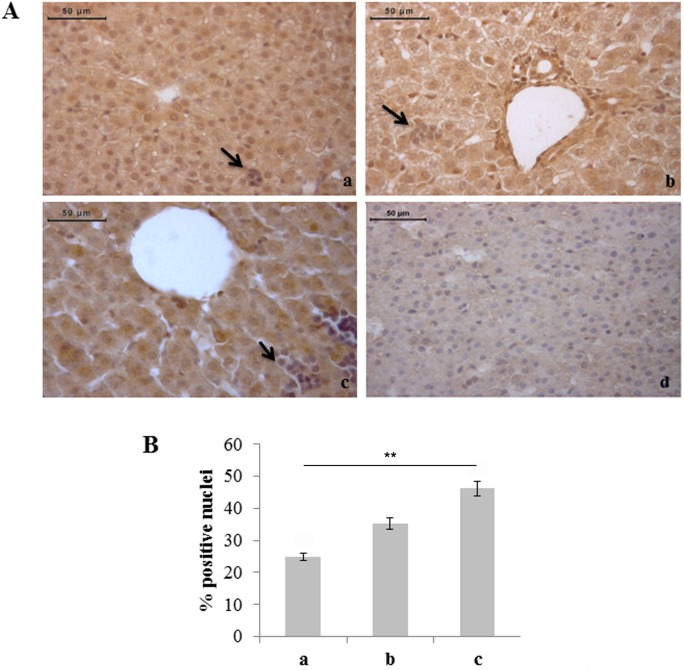
Severe hyperoxia increases eNOS expression in haemopoietic foci.A) Immunohistochemical detection of eNOS-positive haemopoietic cells (arrows) in neonatal rat livers exposed to moderate and severe hyperoxia. a) ambient air; b) 60% hyperoxia; c) 95% hyperoxia; d) negative control; scale bar: 50 µm, magnification 40x. B) Graphic representation of the percentages of eNOS-positive haemopoietic cells (±SD); densitometric analysis determined by direct visual counting of ten fields for each of three slides per sample. ** = p<0.01.